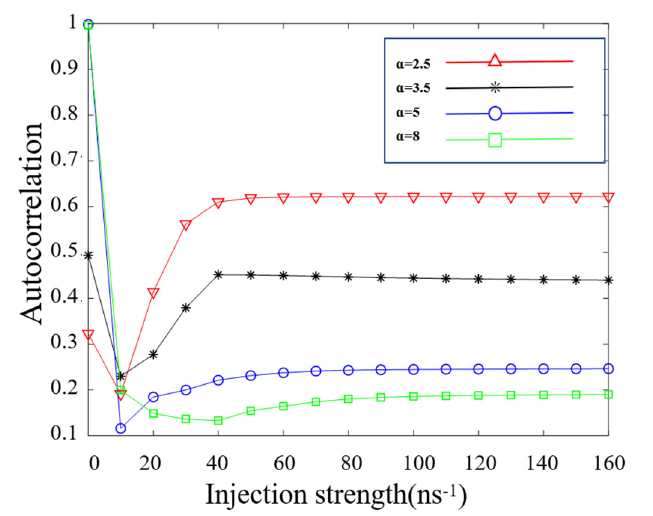
Figure 6. The line diagram of TDS as the injection strength varying from 0 to 160 ns − 1 , where red triangles denote α = 2.5, black stars denote α = 3.5, blue circles denote α = 5, green squares denote α = 8.